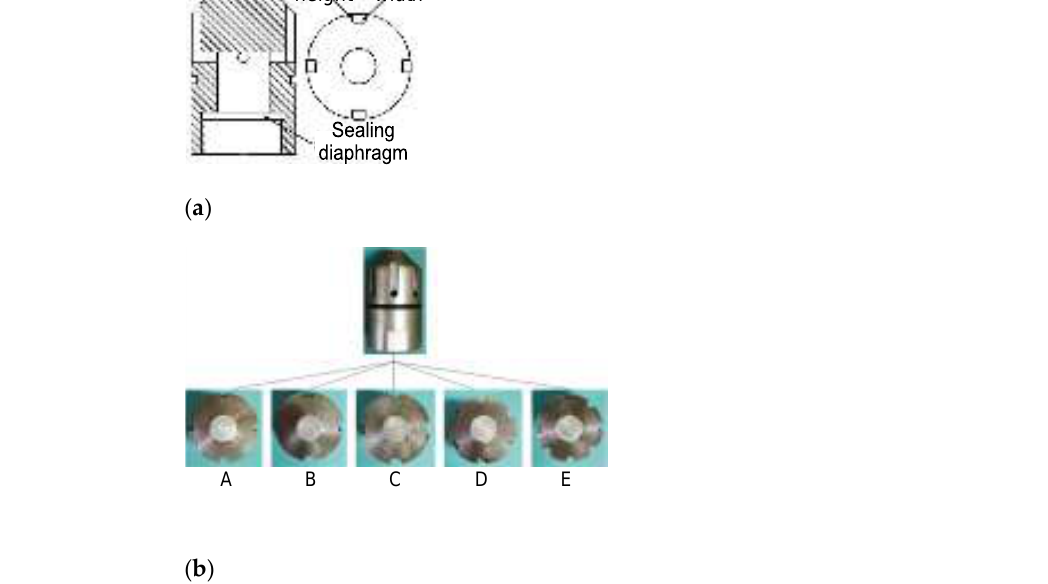
Figure 2. Projectiles: ( a ) structural diagram; ( b ) physical map.